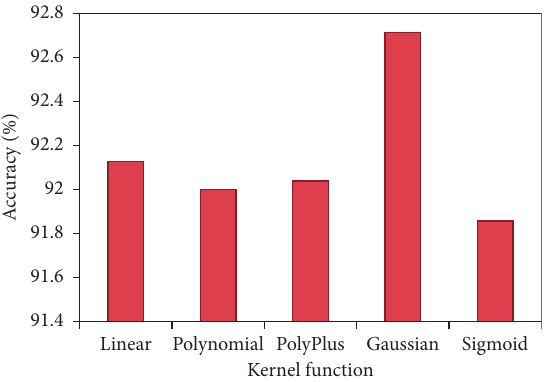
Figure 8: Performance comparison of kernel functions.